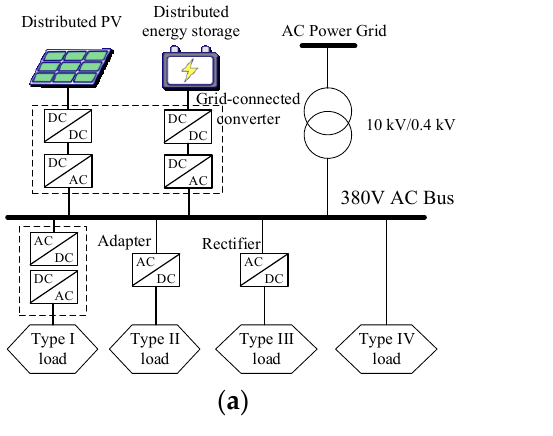
Figure 1. Typical LV distribution system topology: ( a ) AC system; ( b ) DC system. Table 1. Load type